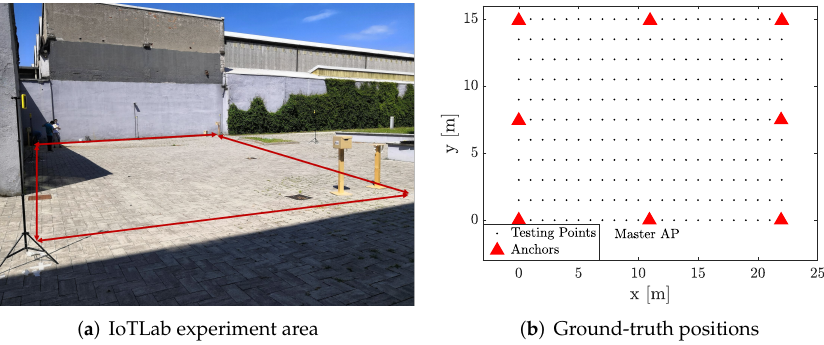
Figure 7. Experimental area: ( a ) picture of the area; ( b ) ground-truth positions of tags and